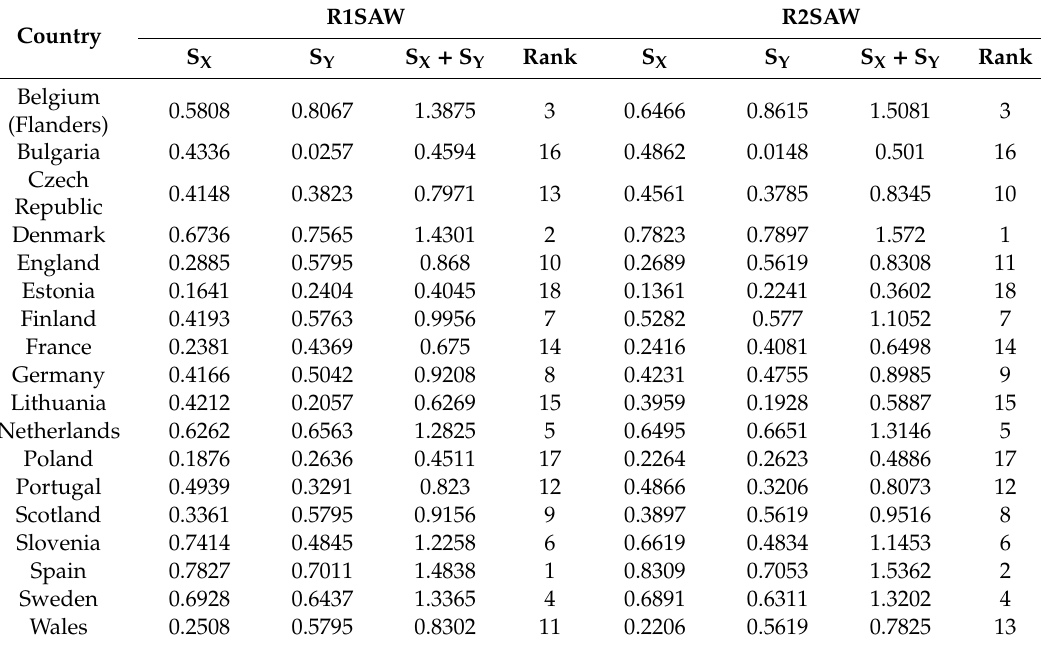
Table 7. Ranking results by R1SAW and R2SAW methods.